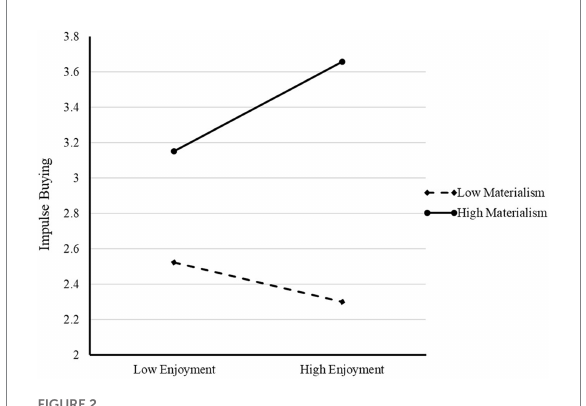
FIGURE 2 Materialism moderates the relationship between enjoyment and impulse buying